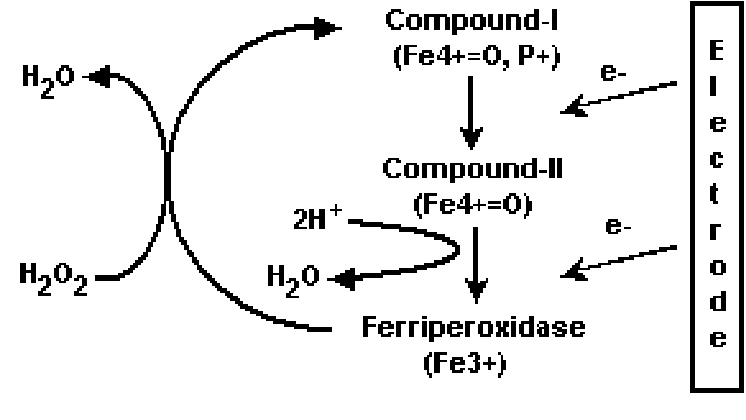
Figure 1. Mechanism of the direct bioelectrocatalytic reduction of hydrogen peroxidase at peroxidase-modified electrodes. P + is a cation radical localized on the porphyrin ring or polypeptide